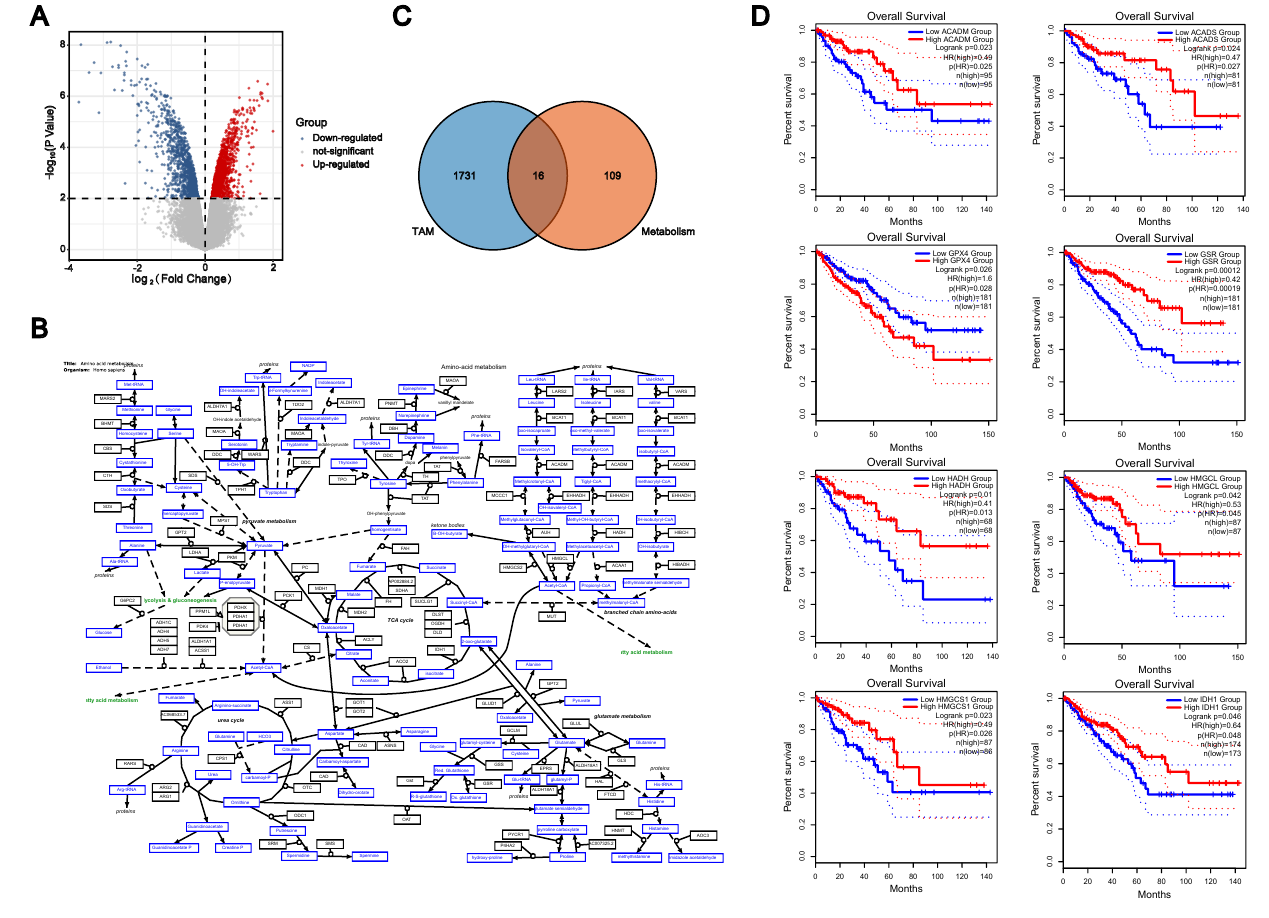
Figure 1. Identification of key enzymes for amino acid metabolism in colon TAMs. ( A ). The mRNA expression levels of colon TAMs and control macrophages from the GSE18804 dataset. ( B ). The cellular metabolic pathway diagram from WikiPathways. ( C ). The Venn diagram of TAM − related genes and amino acid metabolism-related enzymes. ( D ). The survival analysis data of these eight genes in